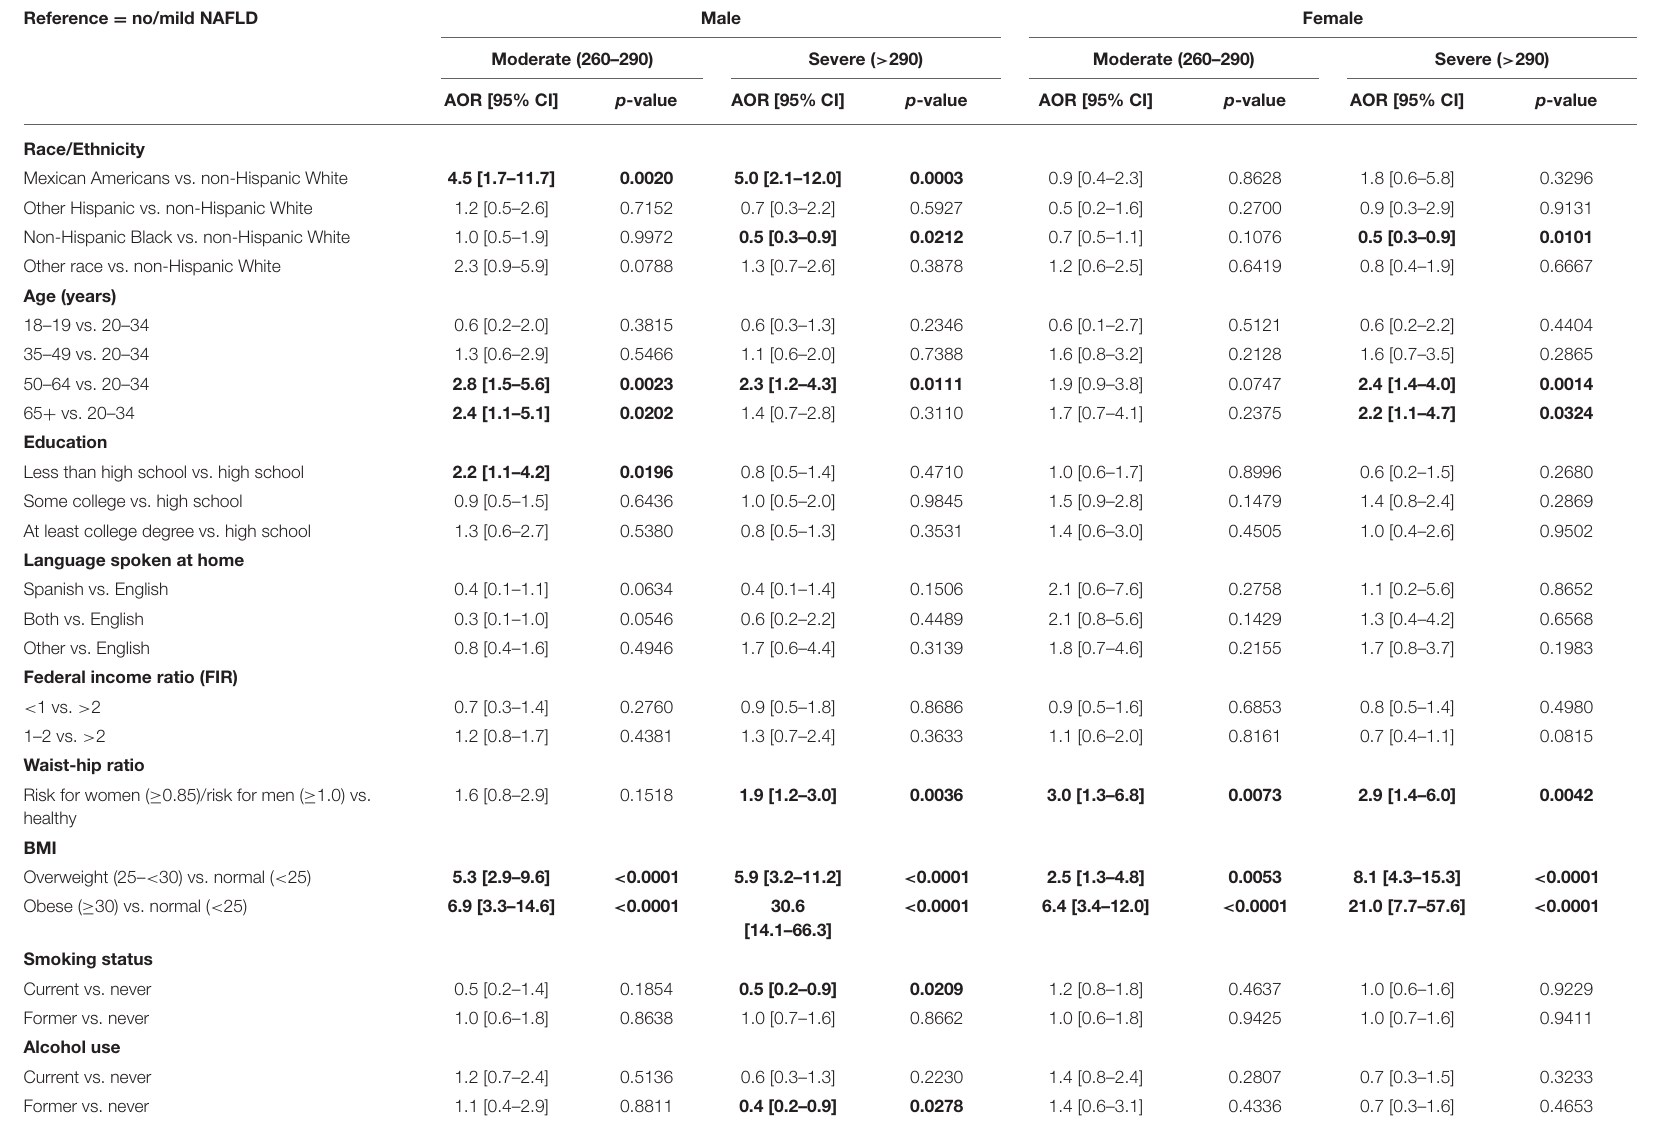
TABLE 6 | Adjusted odds ratio (AOR) and 95% confidence interval (CI) for the relationship between NAFLD and race/ethnicity by gender (reference = no/mild